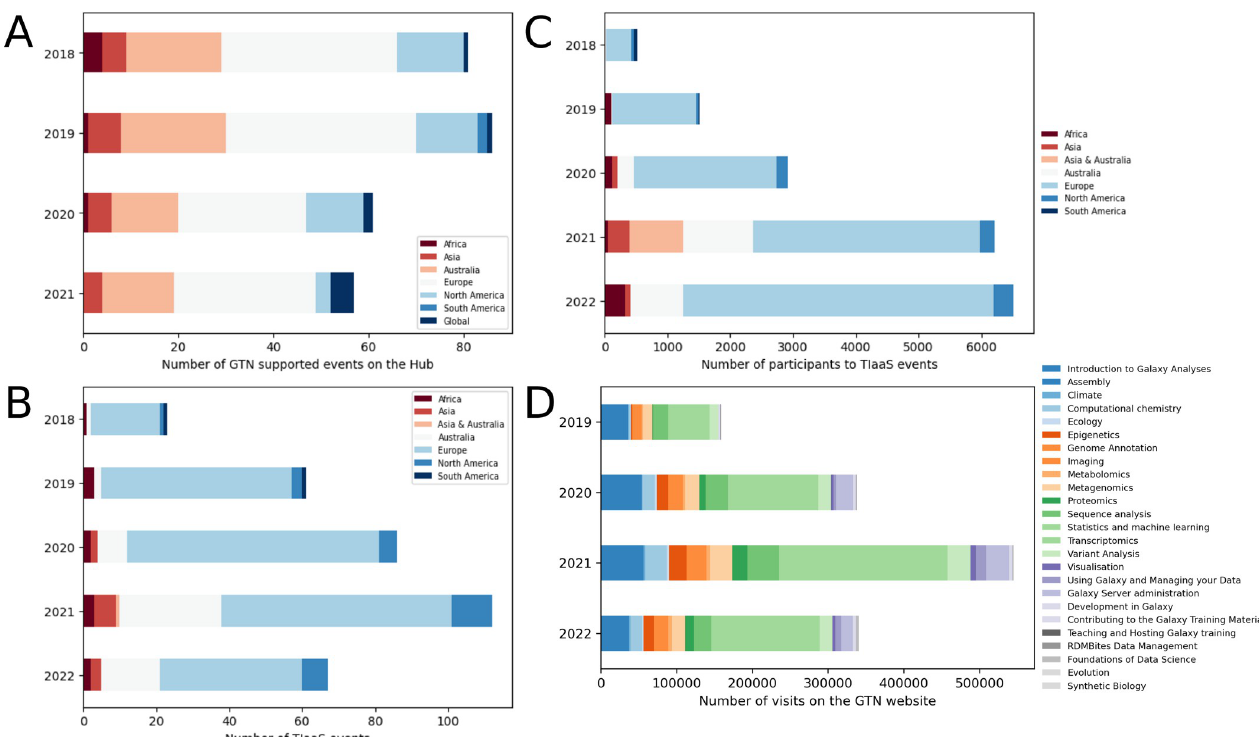
Fig 1. Statistics about training events organized by the Galaxy community and visits of the GTN website over years. (A) Number of events supported GTN materials, registered on the Galaxy Community Hub website [22], per year between 2018 and 2021. (B) Number of TIaaS events per year on Galaxy Europe (collected in May 2022). (C) Number of participants to TIaaS events per year on UseGalaxy. � (collected in May 2022). (D) Number of visits per year on the GTN website and per topics, initially tracked by Google Analytics and later with Plausible (collected in May 2022). The latest usage statistics are publicly available from